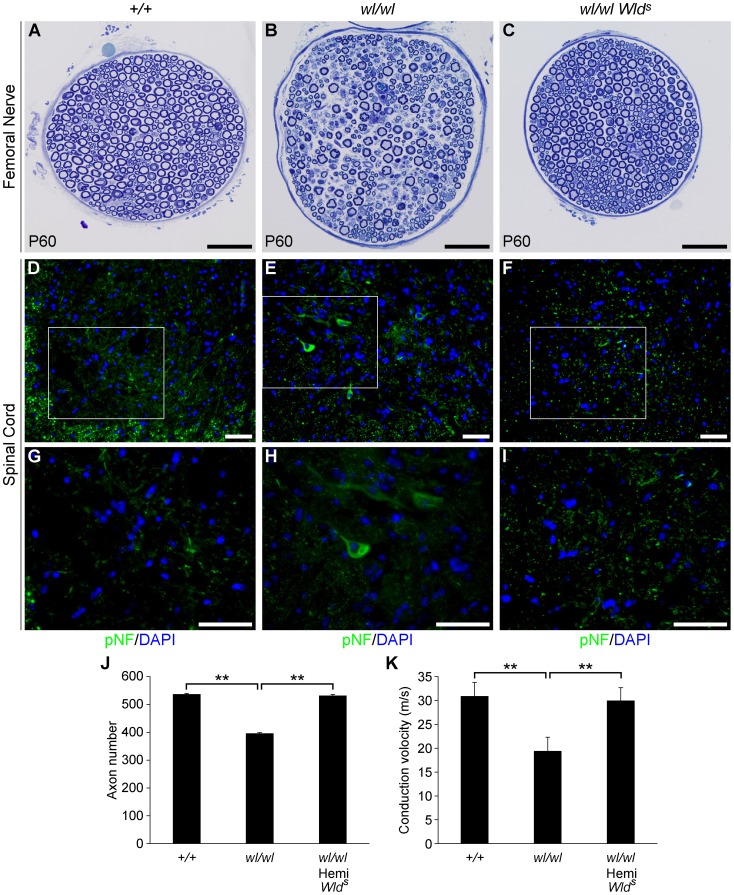
The Wlds mutation delays axonal degeneration in wl (wl/wl) mice.(A–C) Femoral nerves of wild type (+/+), wl/wl and wl/wl Wlds (wl mice hemizygous for a Wlds allele) were examined for axonal degeneration at two months of age. Severe axonal degeneration occurred in wl mutant mice (B), while the Wlds allele significantly delays axonal degeneration (C). Axon morphology wl Wlds was similar to that in wild type control mice. (D–I) Wlds prevented accumulation of pNF (green) in spinal cord soma of wl mutant mice (note, white box in D–F indicates area magnified is G–I). Abnormal accumulation of pNF was observed in the soma of wl mice (E, H) but not wl Wlds mice (F, I). (J) Total number of myelinated axons in the femoral nerve of mice of each genotype at two months of age. Hemizygosity (hemi) for Wlds mice prevented axon loss by this age (n = 4 for each genotype assessed). Number of axons ± sem for mice of each genotype were 537±3 (+/+); 396±3.4 (wl/wl) and 532±4.4 (wl/wl Wlds). (K) Nerve conduction velocity (NCV) was also rescued by Wlds. In wl mice, increased distal latency indicated a reduction in nerve conduction velocity. In the presence of Wlds, NCV was restored to almost control levels (n = 4, for control mice; n = 5 for wl/wl mutant; n = 6 for wl/wl Wlds animals). **, P<0.01; Scale bar, 50 µm.